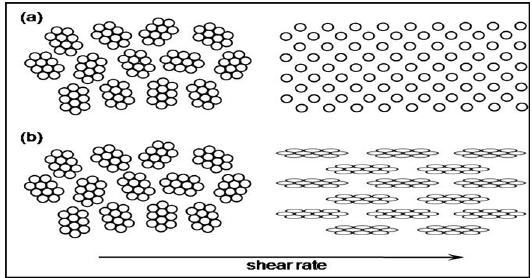
Figure 10. Breaking down of hydroclusters formed by hard particles (a) and deformation of hydroclusters formed by soft particles (b) as the shear rate is